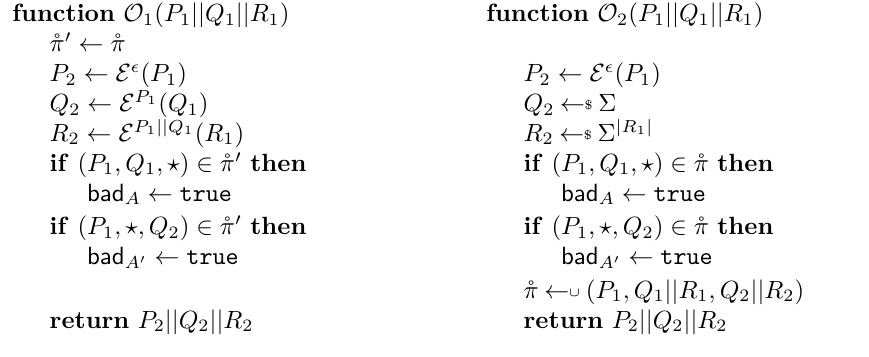
Figure 7: The oracles O 1 and O 2 are identical until bad . In each case they have access to the ideal online permutation E and its internal table ˚ π (See Figure 5). The bad events are equivalent, with the duplicate table ˚ π 0 only used because the E calls in O 1 update ˚ π , rather than it being updated after the bad tests. O 1 is simply the result of expanding out the call to an online cipher via the online property, while O 2 expands out some of the calls before simplifying to something that is identical-until-bad. We use shorthand